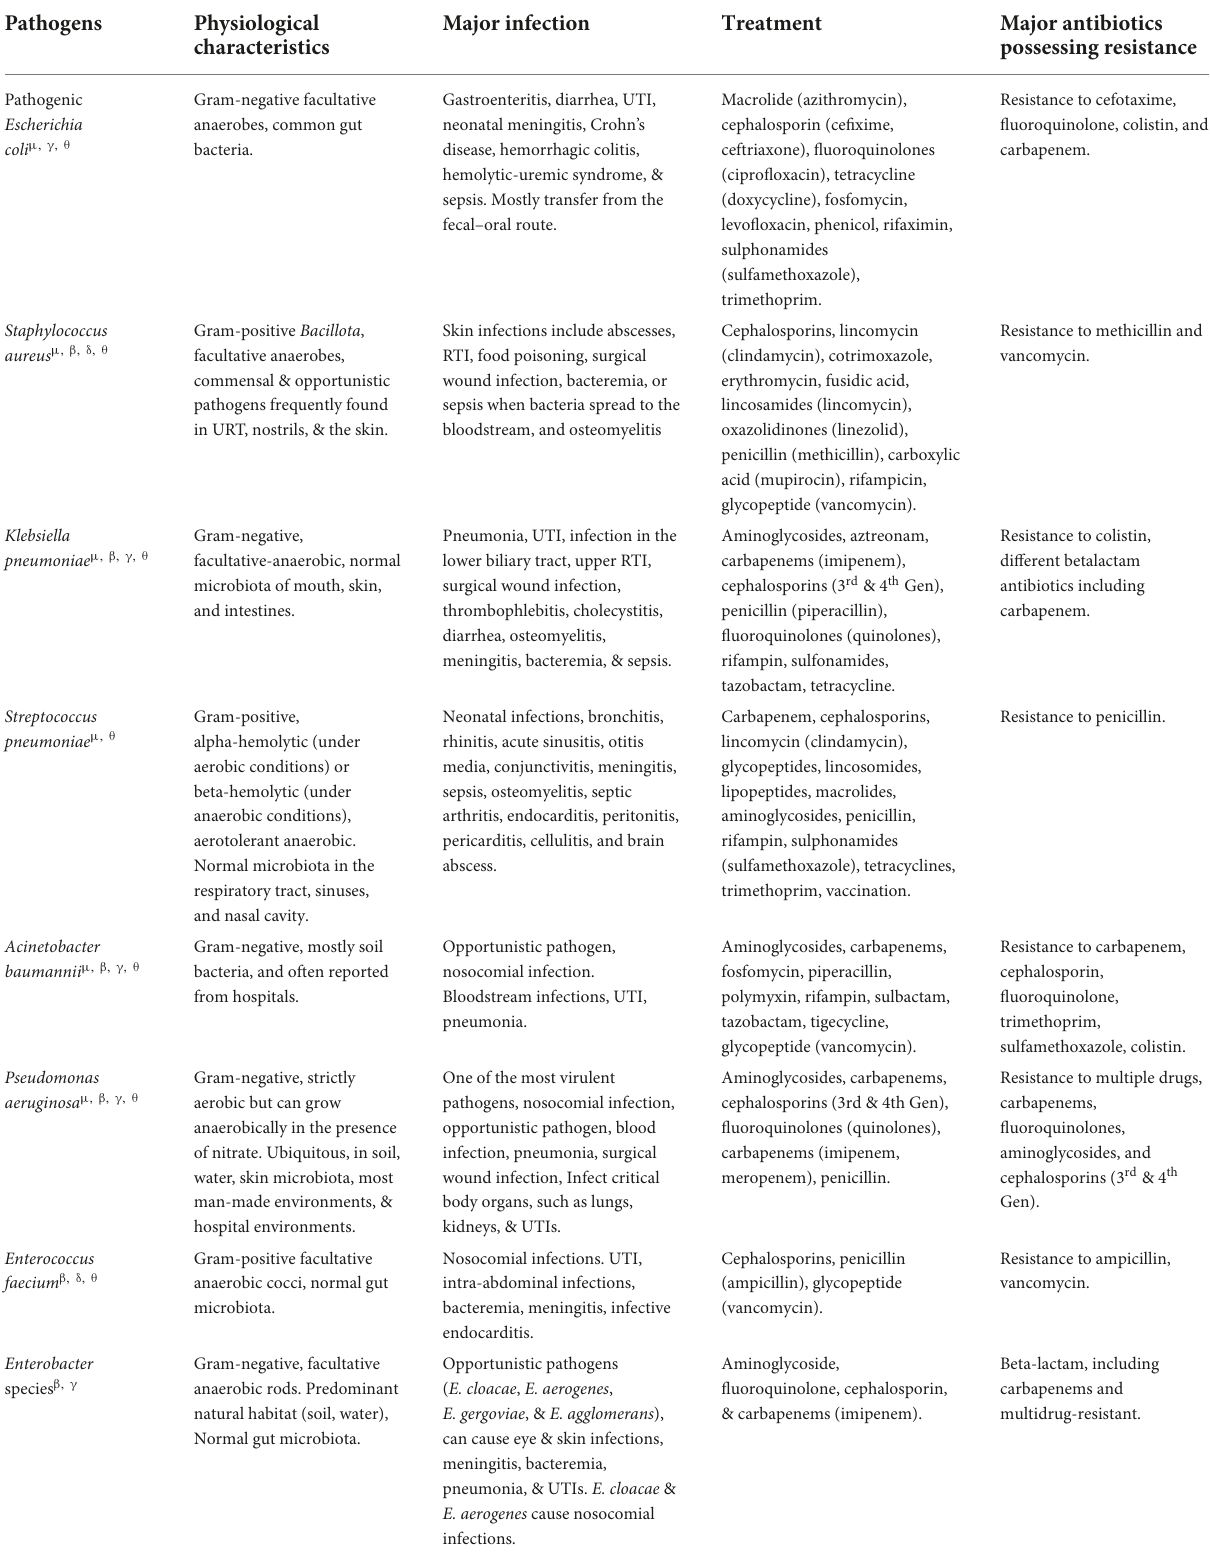
TABLE 1 Characteristics of major antibiotic resistant bacterial